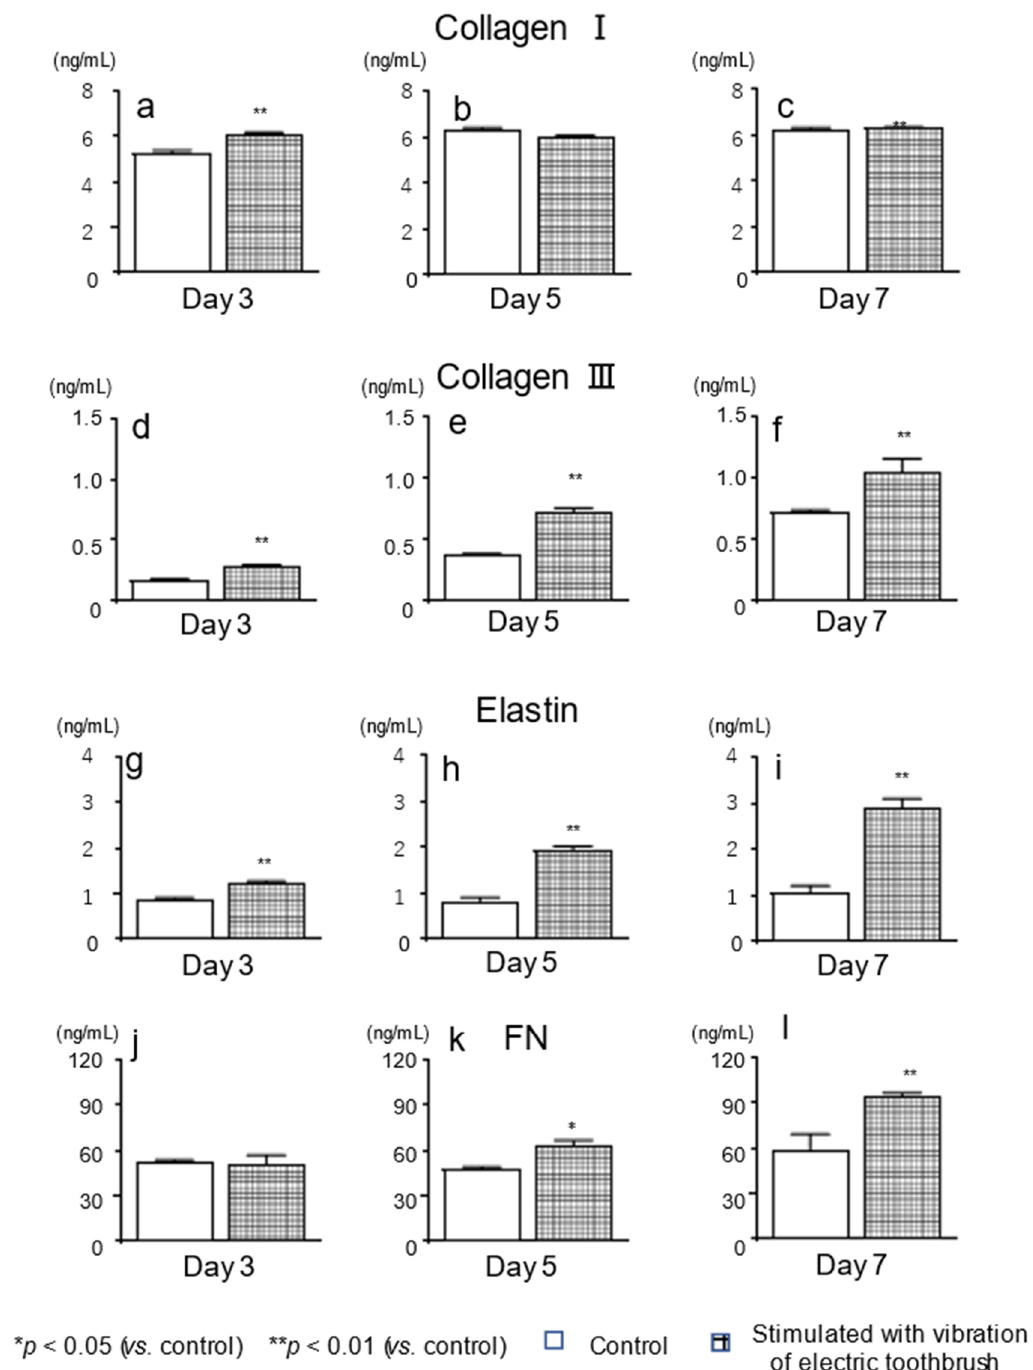
Figure 3. Effects of exposure to vibratory stimulation with an electric toothbrush on protein expression of ECM factors in gingival fibroblasts. HGnFs were exposed to vibratory stimulation with an electric toothbrush for 7 days. The protein expression of four ECM factors ( a – l ) in the culture supernatants and lysate was quantified using ELISA. Each bar indicates mean ± standard deviation (SD) of five independent experiments. * p < 0.05, ** p < 0.01 (vs.